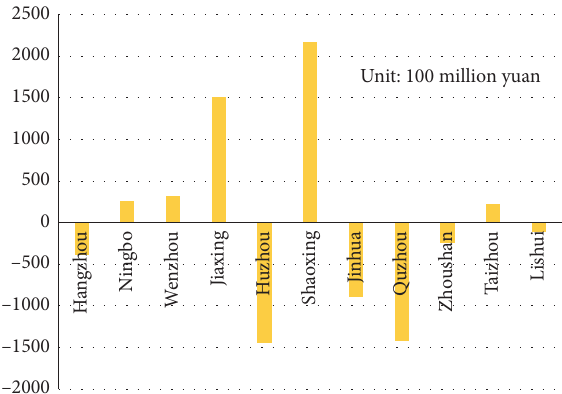
Figure 4: Comparison of competitiveness shift component of secondary industry.